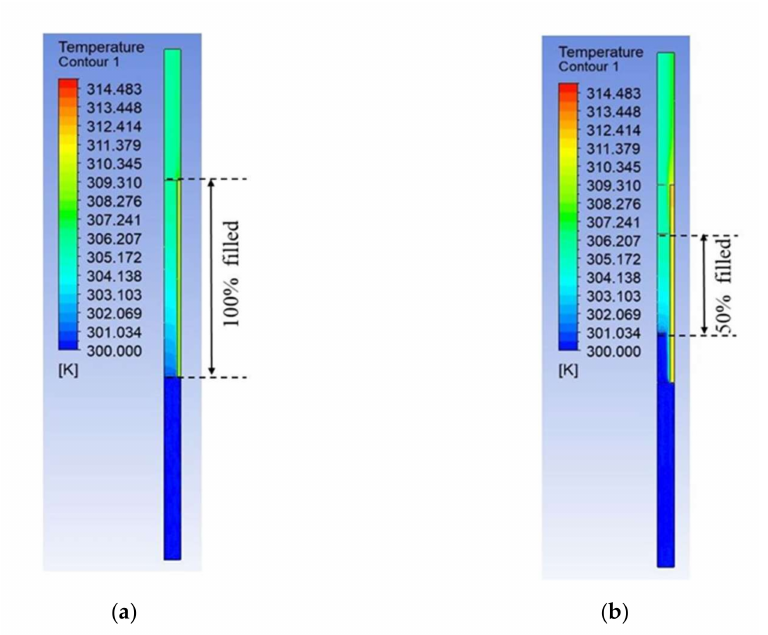
Figure 9. ( a ) Temperature contours of 100% thickness of 0.95 porosity 10 PPI foam. ( b ) Temperature contours of 50% thickness of 0.95 porosity 10 PPI